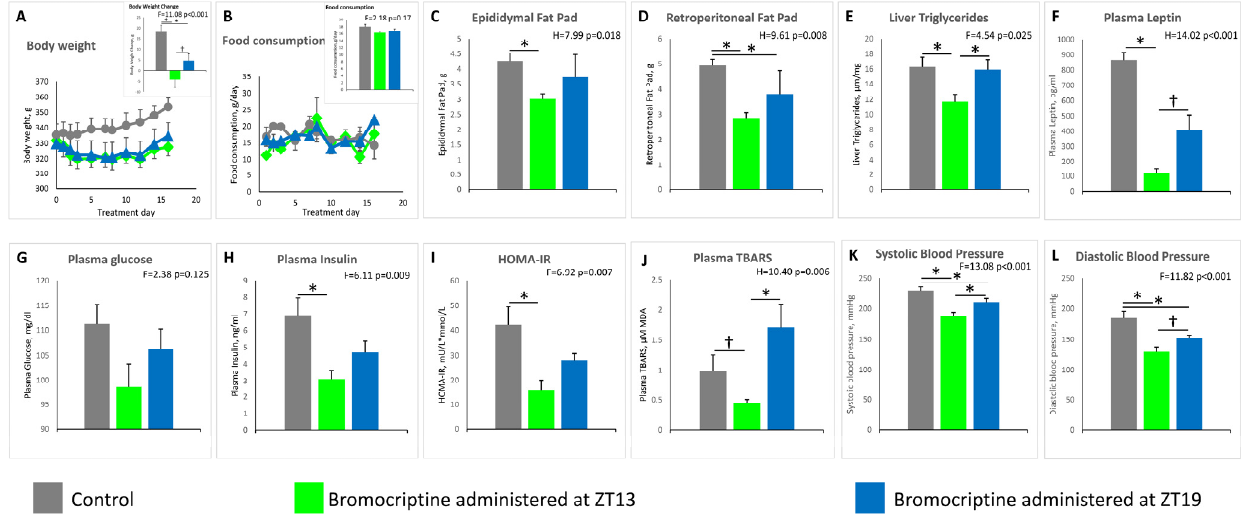
Figure 2. Impact of the timed daily bromocriptine (at ZT 13 or ZT 19) or control treatment for 16 days on metabolic syndrome parameters. Effects were examined using 1-way ANOVA (F) followed by pairwise post hoc (Holm–Sidak method) for normally distributed data, or Kruskal–Wallis (H) one-way analysis of variance on ranks test followed by Dunn’s pairwise multiple comparison procedures test for non-normal data, see Methods. Significant pairwise comparisons revealed from post hoc analysis or Dunn’s test are indicated by horizontal bars with *— p < 0.05, 2-sided; †— p < 0.05, 1-sided (see Results for details of individual parameter comparison p